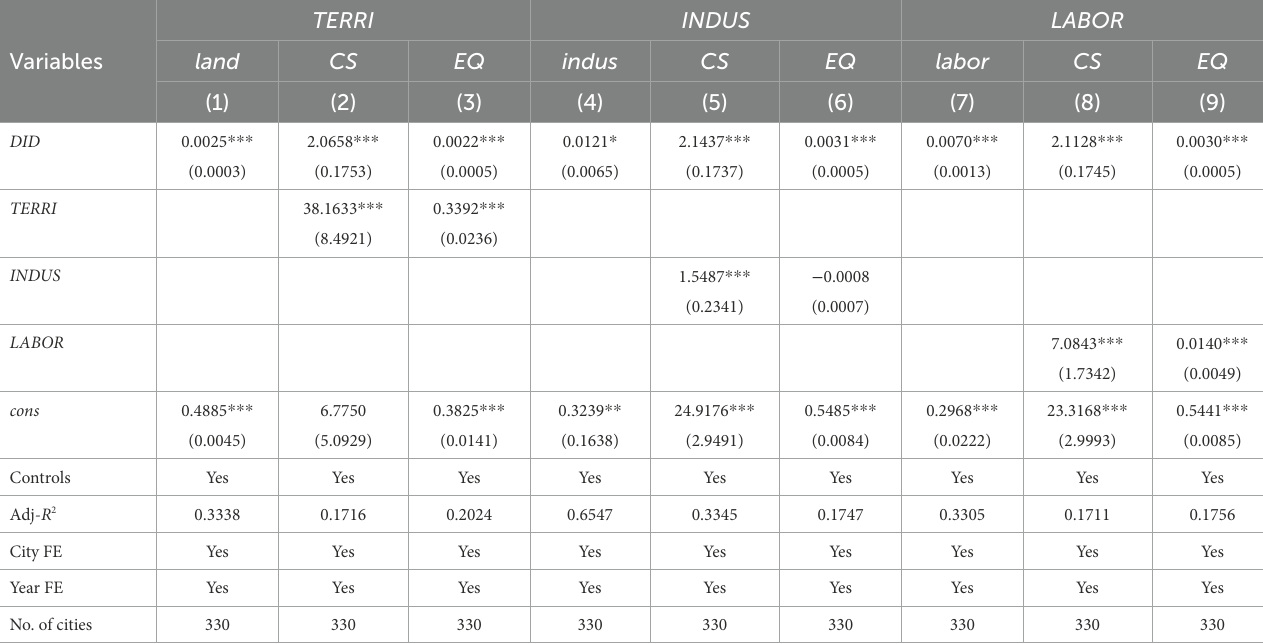
TABLE 4 The results of mechanism